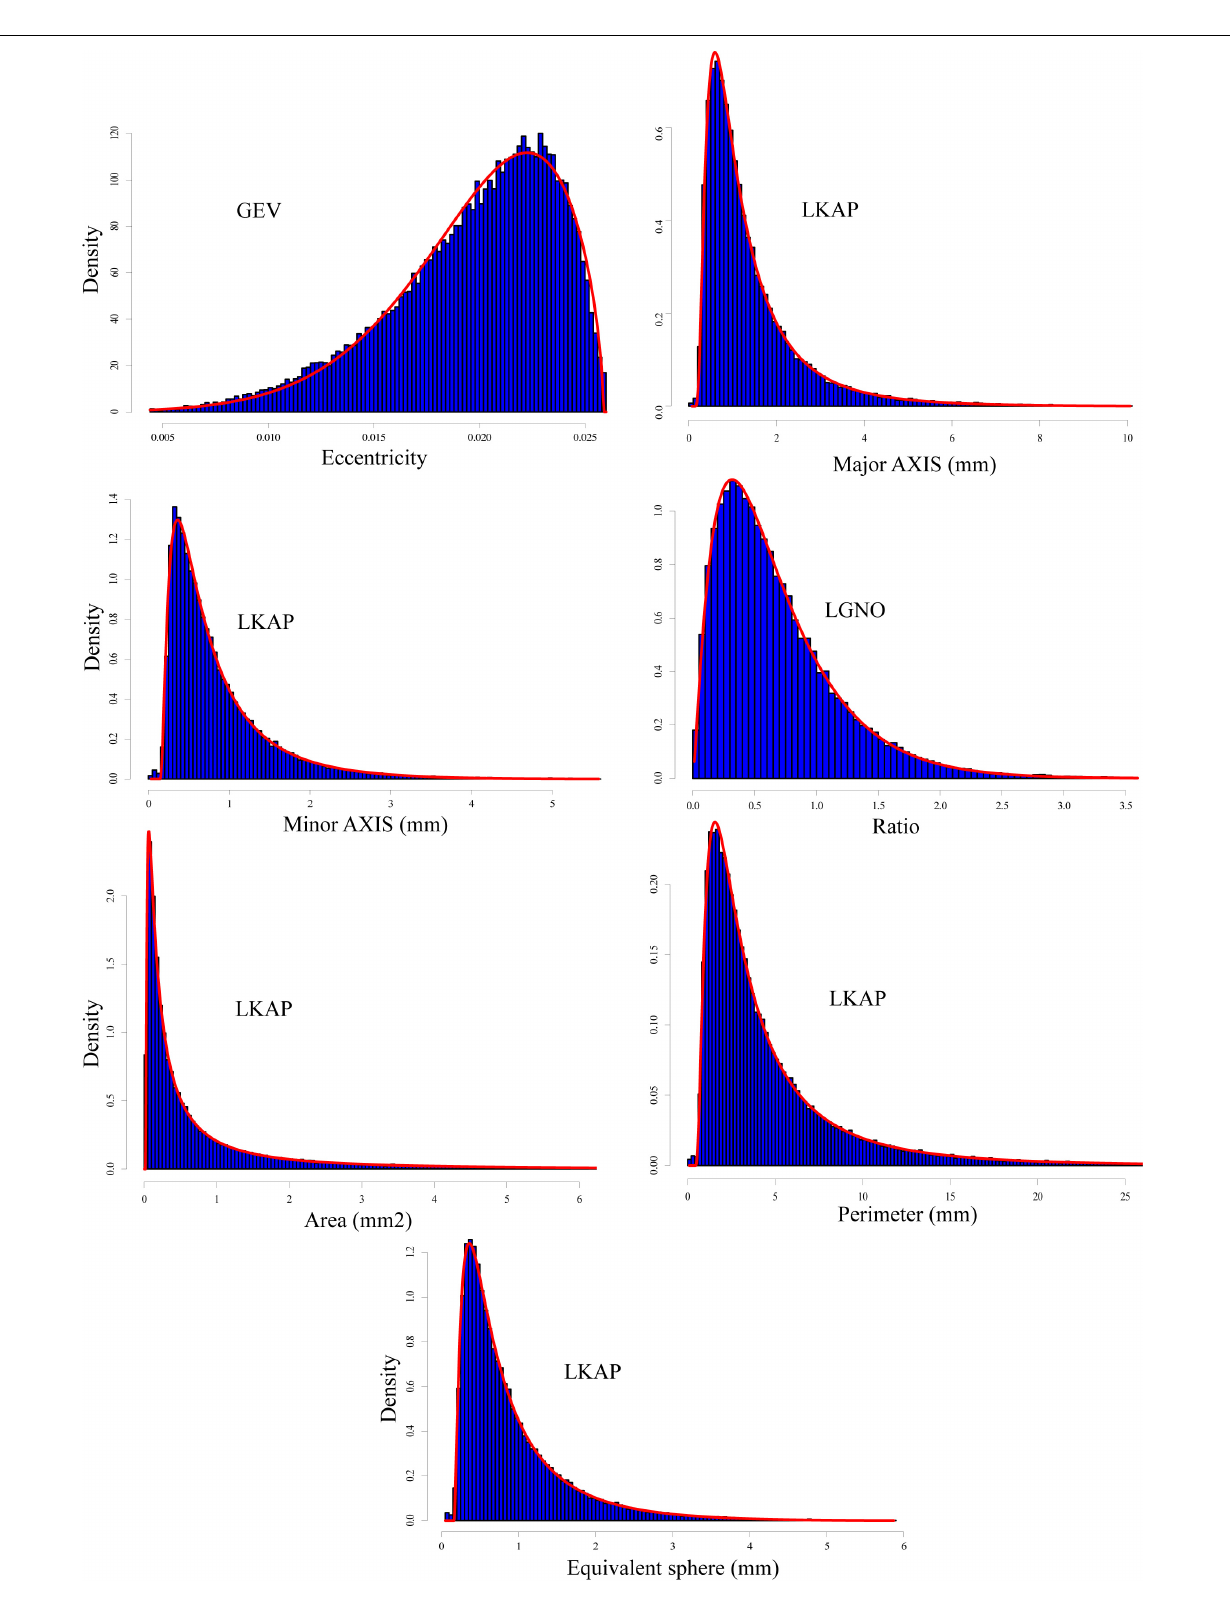
Frontiers in Earth Science |